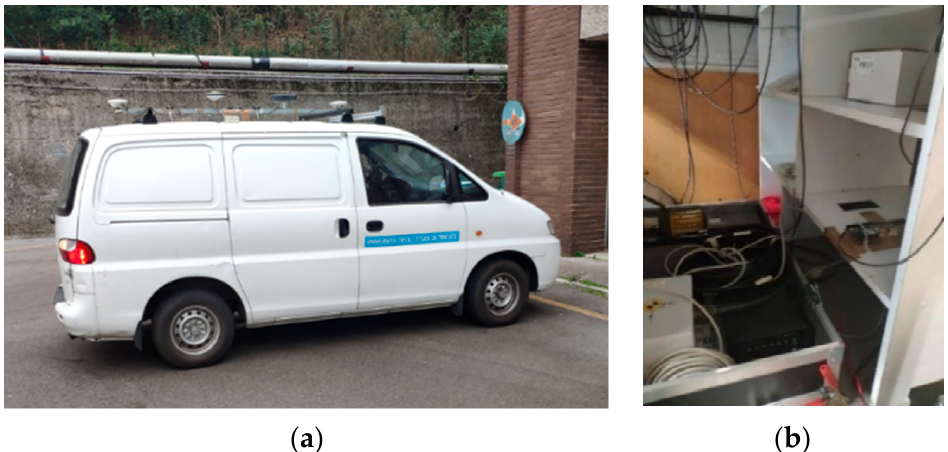
Figure 1. ( a ) The MMS of the GeoSNav Lab vehicle, University of Trieste, with the GNSS antennas mounted on the roof; ( b ) the setup of the instruments inside the vehicle.